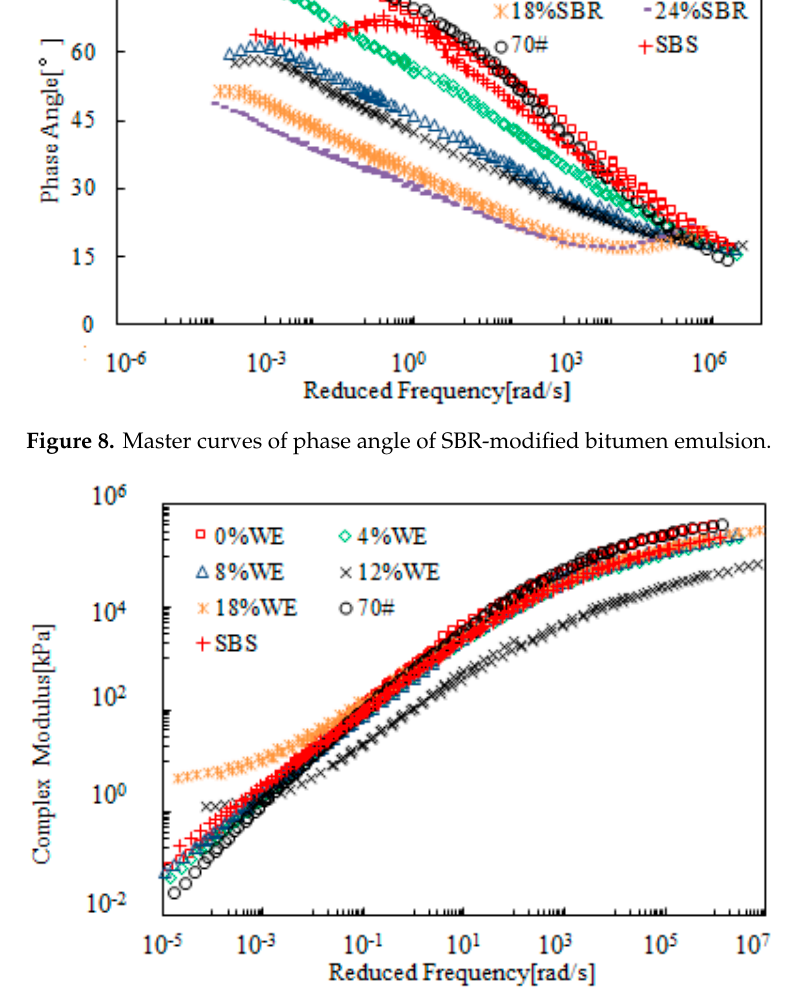
Figure 8. Master curves of phase angle of SBR-modified bitumen emulsion.